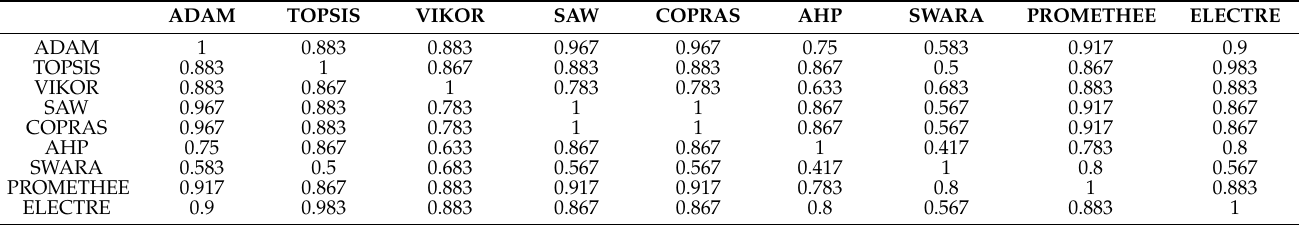
Table 9. SCC values of method comparisons.